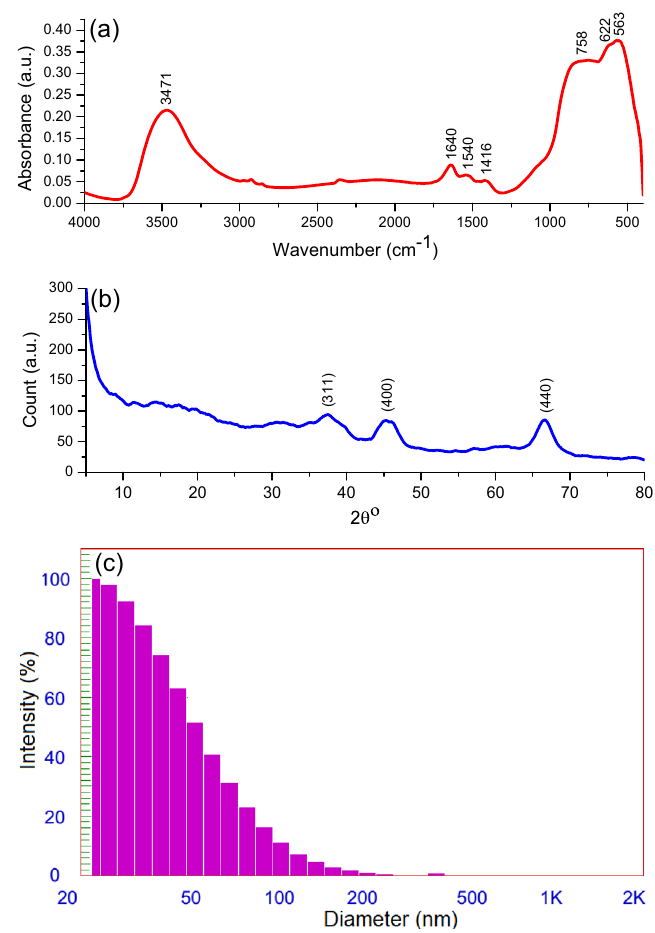
Figure 2. ( a ) FTIR spectrum, ( b ) XRD spectrum, and ( c ) particle size distribution of fabricated mesoporous